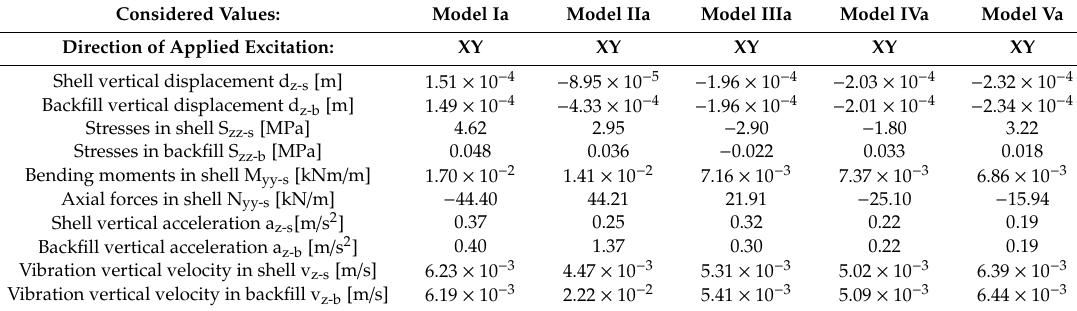
Table 1. The results of the numerical analyses of the soil–steel bridge with and without the EPS, under rockburst excitation (anthropogenic) simultaneously in two directions (XY).